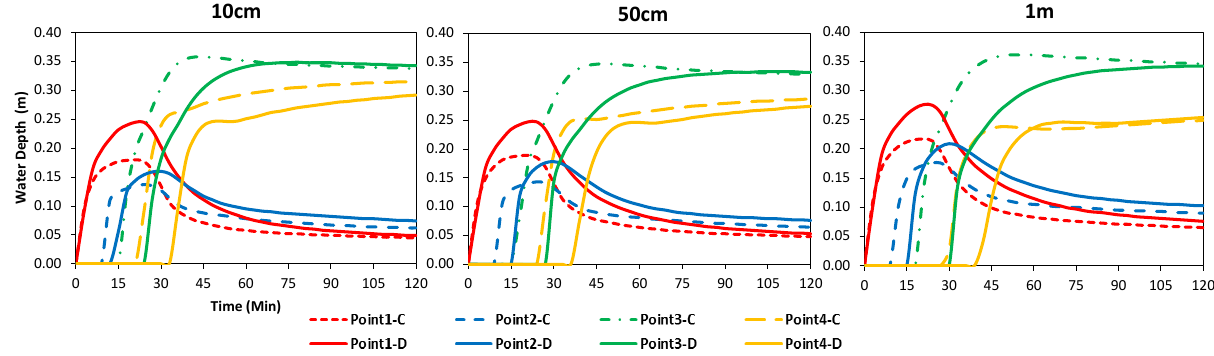
Fig. 8. Profiles of simulated water depth through time at the four control points at 1x =10cm, 50cm and 1m using Composite ( C ) and Distributed ( D ) roughness conditions.